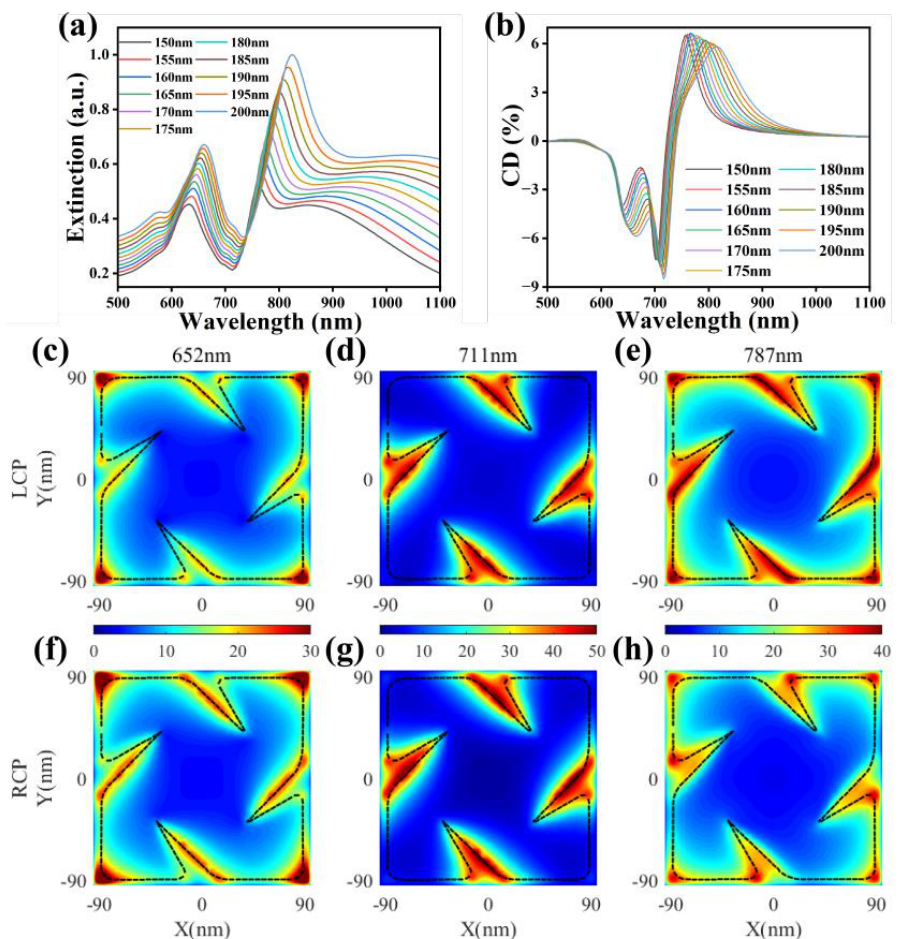
Figure 2. ( a ) Extinction and ( b ) CD spectra of the single GHNP with different nanoparticle side length l . ( c – h ) Electric field distribution of three modes shown in CD spectra when l = 180 nm. Their resonance positions are 652 nm, 711 nm, and 787 nm. Figure ( c – e ) and ( f – h ) indicate LCP and RCP incidence, respectively.